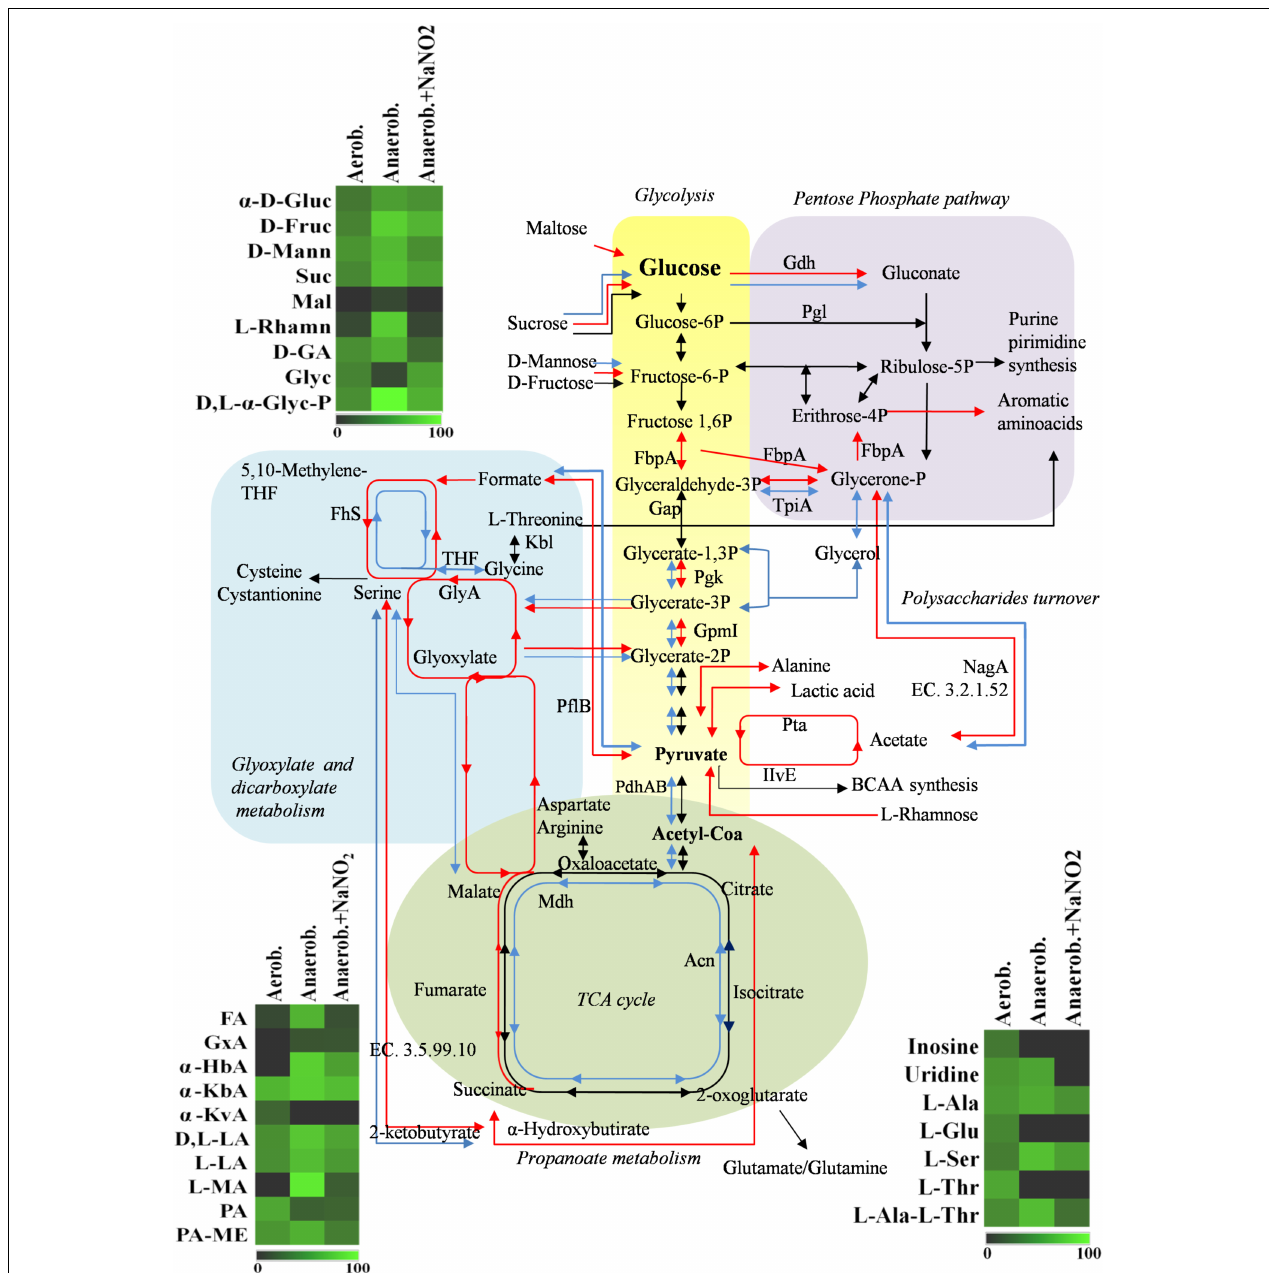
FIGURE 3 | Schematic representation of changes in DSM 20266T metabolism. Colored arrows and enzymes indicate metabolic pathways induced (false discovery rate, FDR < 0.05) under anaerobiosis without nitrite (red line) or under anaerobiosis in presence of nitrite (blue line) in comparison to metabolic pathways detected under aerobiosis (dark line). Heatmap inserts compare phenotypic microarrays based on assimilation substrate by DSM 20266T strain upon different growth conditions. The legend of color code from black to dark green, and chartreuse green indicate low, moderate, and high utilization of carbon and nitrogen sources, respectively, assessed as arbitrary Biolog values. Substrates: FA, fumaric acid; GA: glyoxylic acid; α -HbA, α -hydroxybutyric acid; α -KbA, α -ketobutyric acid; α -KvA, α -ketovaleric acid; D , L -LA, D , L -lactic acid; L -LA, L -lactic acid; MA, L -malic acid; PA, pyruvic acid; PA-ME, pyruvic acid methyl ester; α - D -Gluc, α - D -glucose; D -Fruc, D -fructose; D -Mann, D -mannose; Mal, maltose; D -GA, D -gluconic acid; Glyc, glycerol; D , L - α -Glyc-P, D , L - α -glycerol-P; Inosine, inosine; Uridine, uridine; L -Ala, L -alanine; L -Glu, L -glutamic acid; L -Ser, L -serine; L -Thr, L -threonine; L -Ala- L -Thr, L -alanyl- L -threonine; Enzymes: Gdh, sugar dehydrogenase; TpiA, triosephosphate isomerize; Gap, glyceraldehyde-3-phosphate dehydrogenase; IlvE, branched-chain-amino-acid aminotransferase; MetB, cystathionine gamma-synthase; PhdA, pyruvate dehydrogenase E1 component alpha subunit; PdhB, pyruvate dehydrogenase E1 component beta subunit; Pgk, phosphoglycerate kinase; Kbl, glycine C -acetyltransferase; GlyA, serine hydroxymethyltransferase; GpmI, phosphoglyceromutase; Mdh, malate dehydrogenase; Pgl, 6-phosphogluconolactonase; Fhs, formate-tetrahydrofolate ligase; NagA, N -acetylglucosamine-6-phosphate deacetylase; Acn, aconitate hydratase; Pta, phosphate acetyltransferase; FbpA, fructose-bisphosphate aldolase; PflB, formate C -acetyltransferase; EC 3.5.99.10 RidA family protein; EC 3.2.1.52 Beta-hexosaminidase.